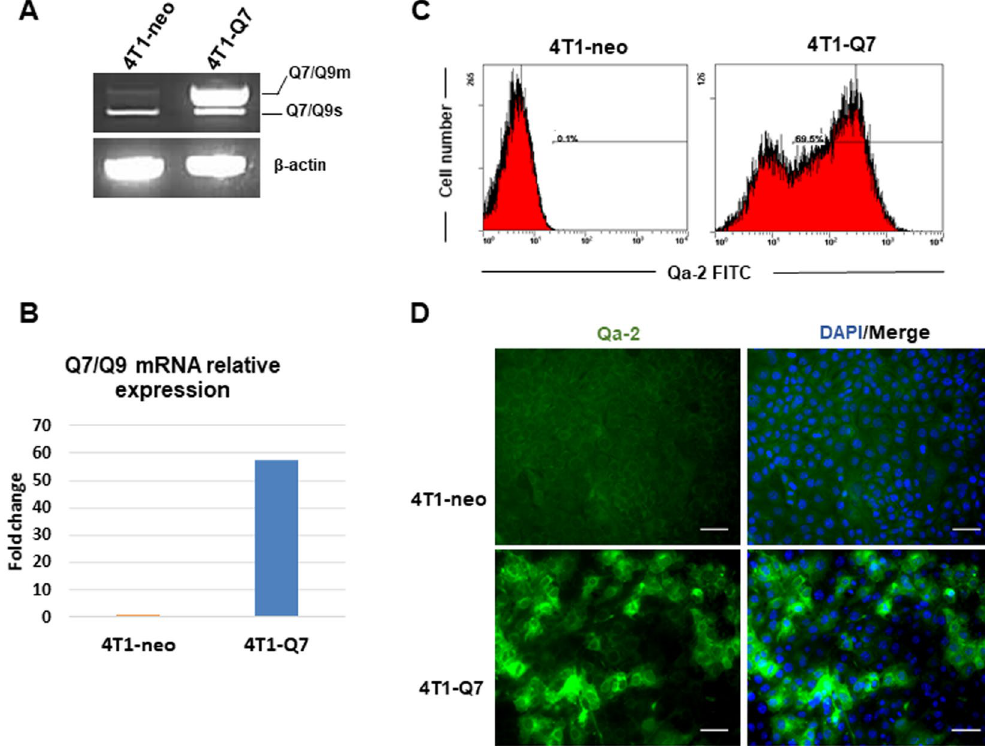
Figure 7. Stable transfection of Q7 cDNA into 4T1 cells. ( A ) Semiquantitative RT-PCR analysis of Q7 expression. Q7/Q9m, membrane-associated form; Q7/Q9s, soluble form. ( B ) Analysis of Q7 mRNA expression. Transcript levels were measured by real-time qRT-PCR, normalized to β -actin mRNA levels, and values for 4T1-Q7 were compared to 4T1-neo, which were given an arbitrary value of 1. ( C ) Analysis of Q7 cell-surface expression by flow cytometry. ( D ) Immunofluorescence detection of Q7. Nuclei were stained with DAPI. Bars, 100 μ